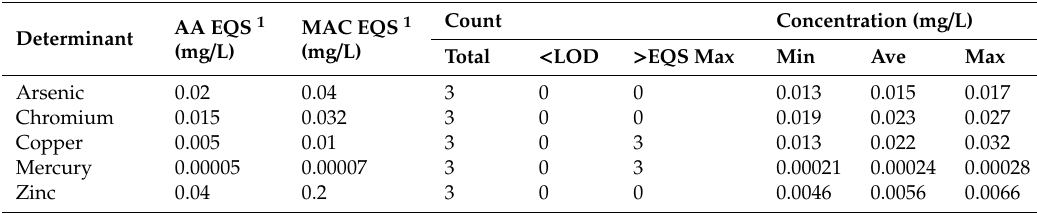
Table 1. Summary of WAC leachate concentrations for raw